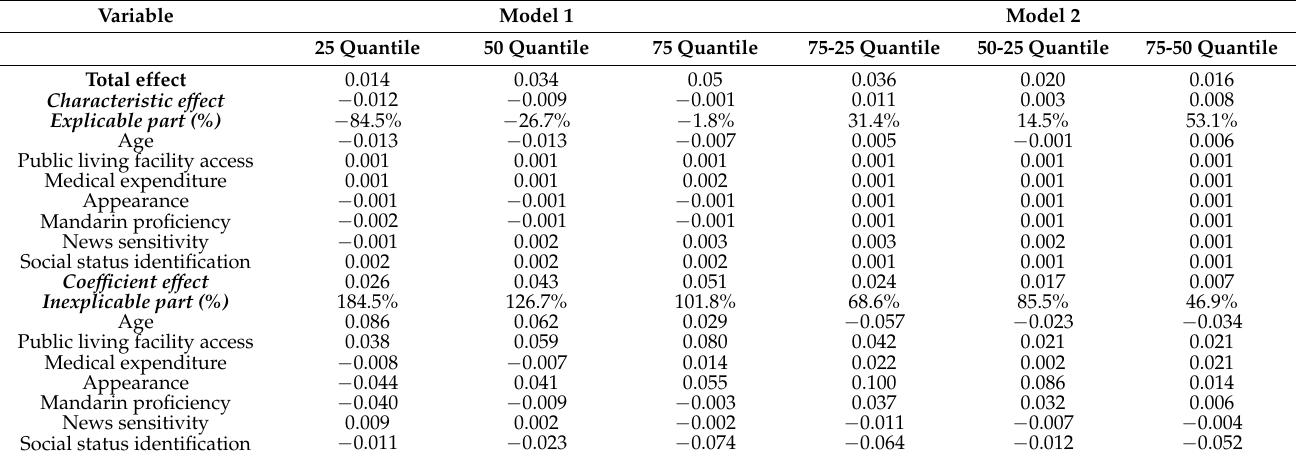
Table 6. Results of the UCQR decomposition of migrant workers’ relative